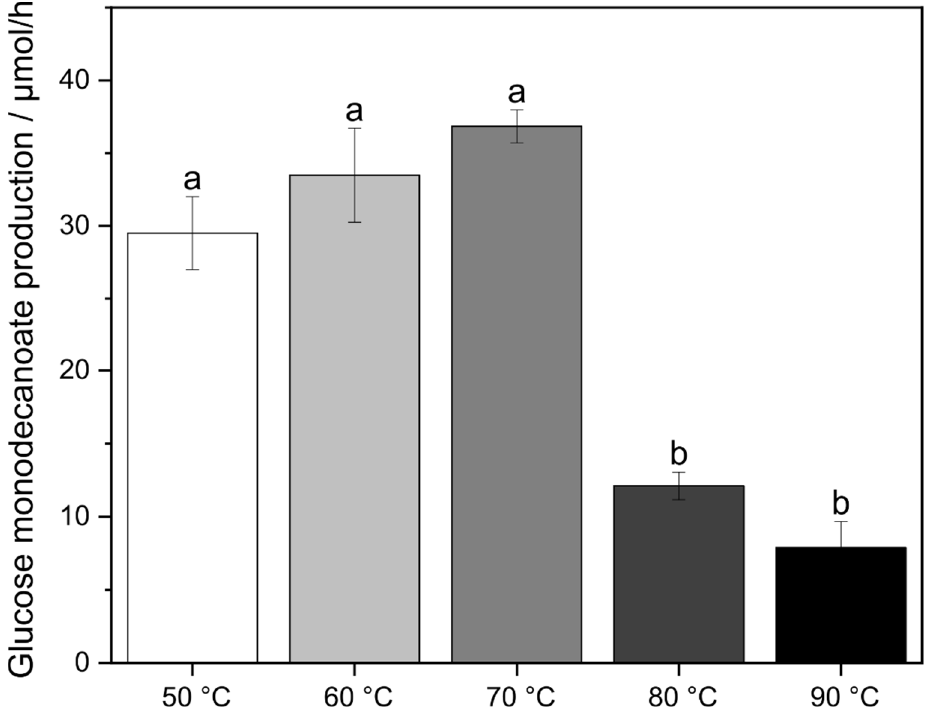
Figure 2. Influence of temperature on glucose monodecanoate production. a, b show statistically significant differences (one-way ANOVA, Tukey’s test, p < 0.05).